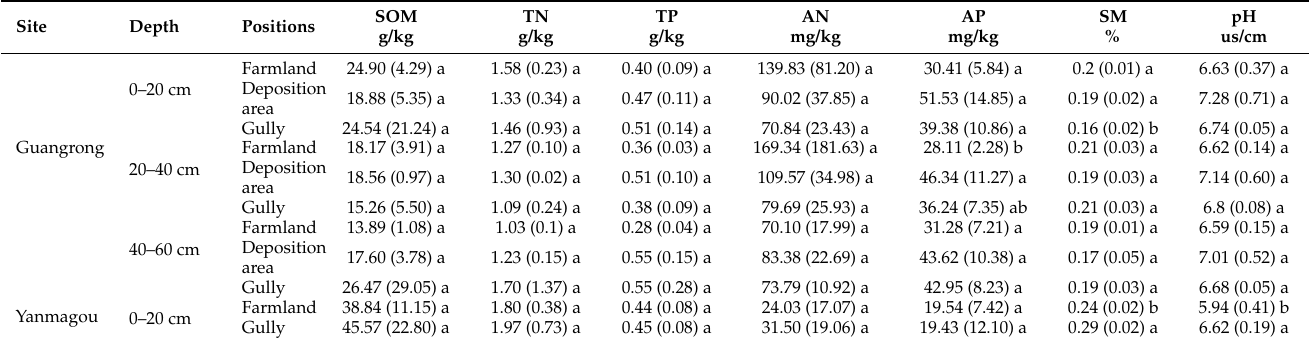
Table 1. Soil physicochemical properties in the Guangrong site and Yanmagou